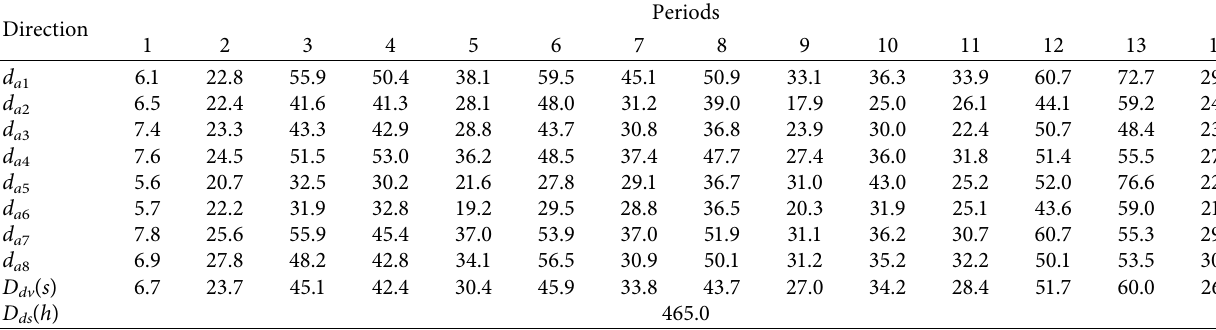
Table 11: Analysis results of the average vehicle delay in scheme D. Direction